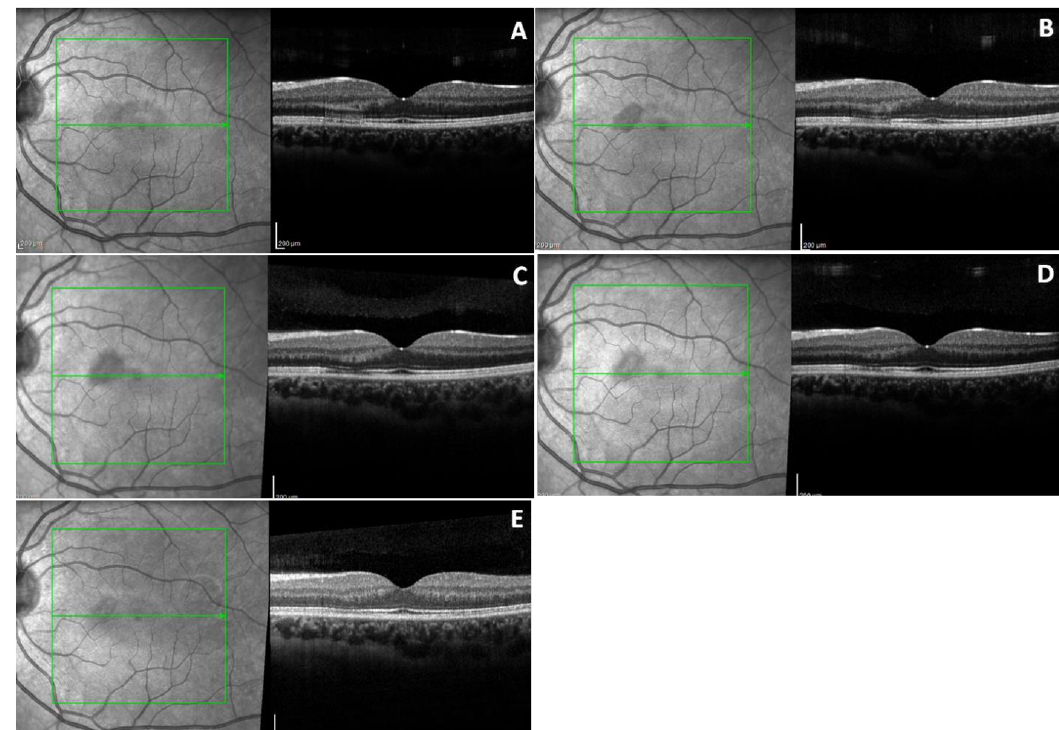
Figure 1. Optical coherence tomography (OCT) and infrared (IR) images of left eye. ( A ) At presentation IR shows hyporeflective parafoveal lesion. Corresponding OCT shows a hyperreflective band of outer plexiform layer (OPL) and outer nuclear layer (ONL), and alteration of inner segment/outer segment (IS/OS) and retinal pigment epithelium (RPE). ( B ) Imaging one week later. ( C ) 40 days later, the OCT features started to normalize. ( D ) One year later, the OCT shows a smaller band in the OPL. ( E ) 30 months later, the lesion on the IR image is reduced and there are hyperreflective spots in the OPL and hyporeflective band of the ellipsoid zone .